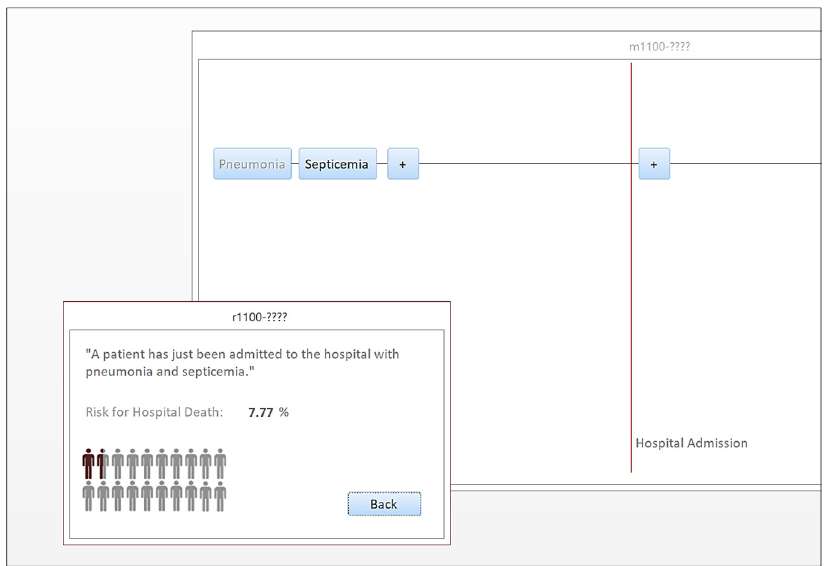
Figure 4. An instance of the INP applet. The user initiated a scenario, of a community pneumonia which progressed to septicemia before the hospital-admission, to see the risk for hospital death.